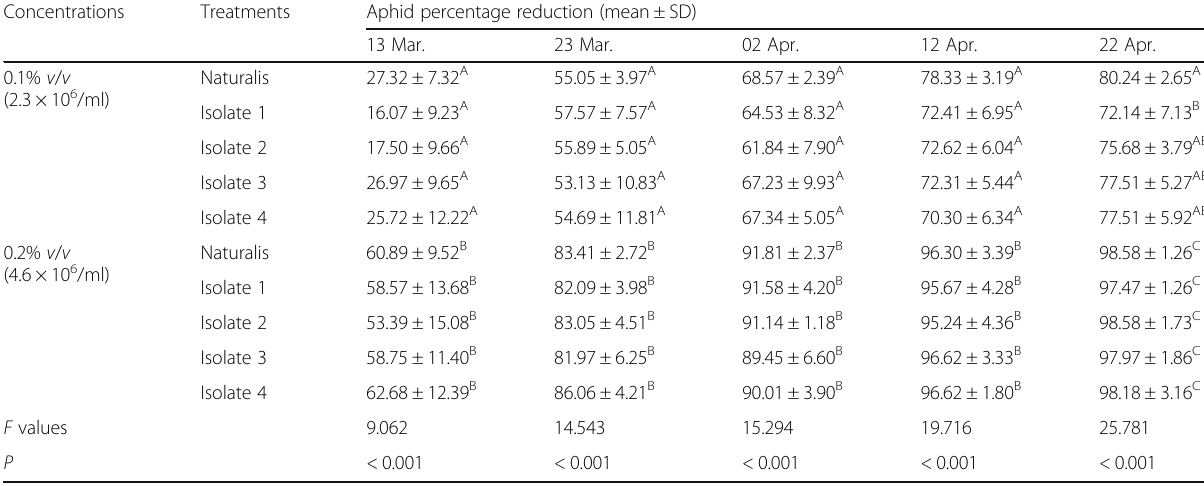
Means within each column bearing different letters are significantly different according to Duncan test ( P